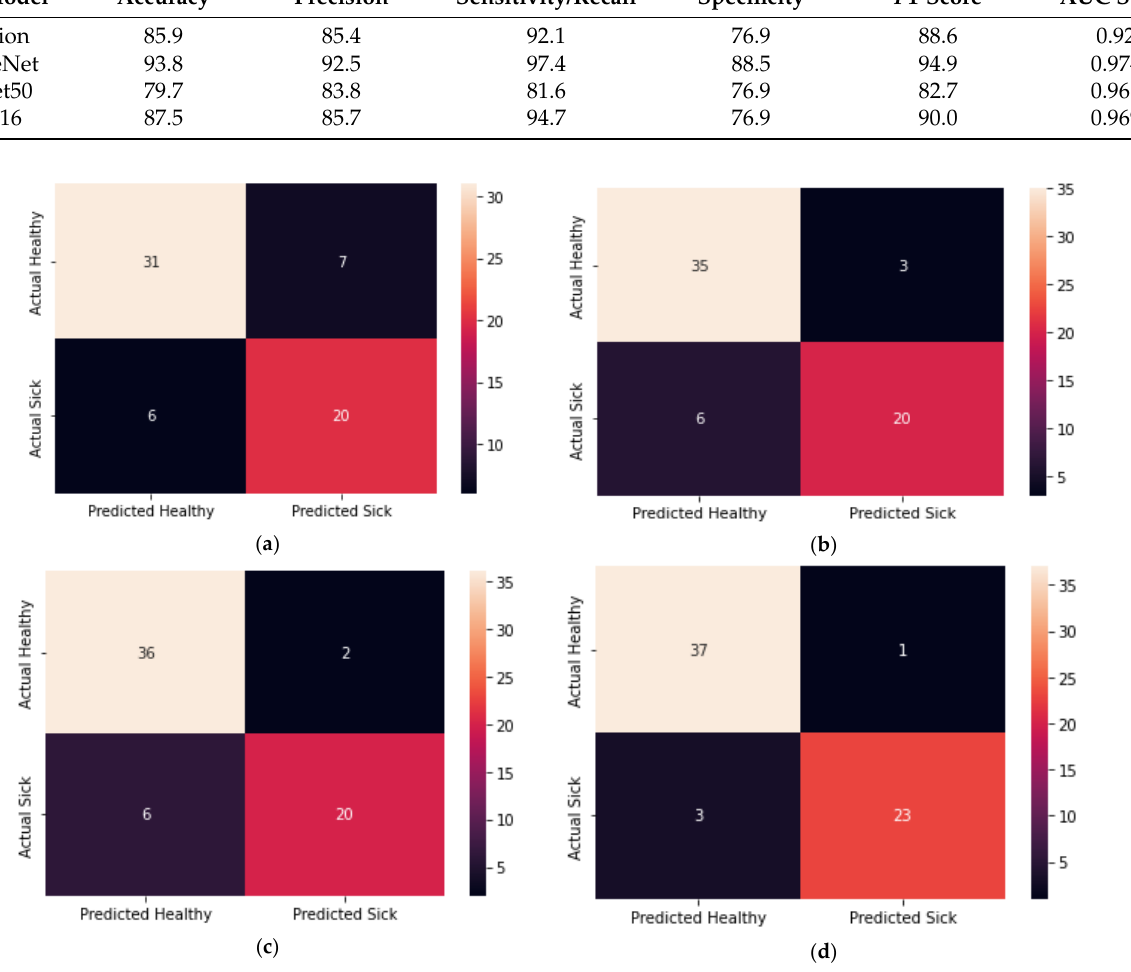
Figure 5. Confusion matrix of transfer learning approach models ( a ) ResNet50 ( b ) Xception ( c ) VGG16 ( d ) MobileNet.